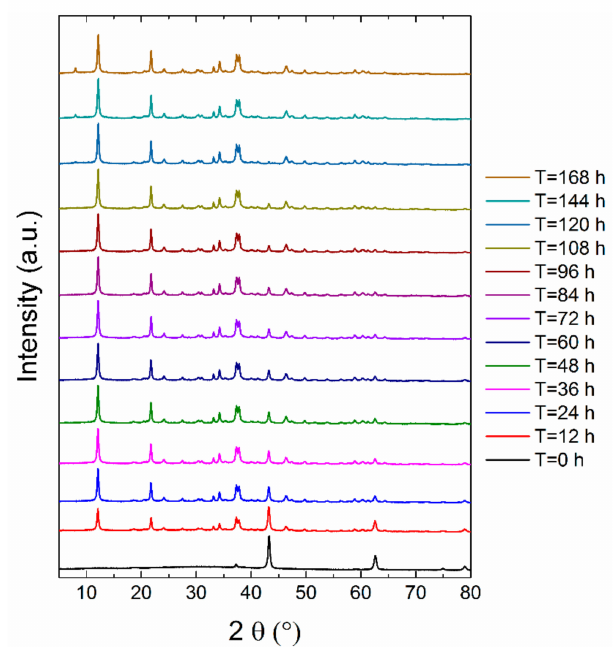
Figure 1. X-ray powder di ff raction (XRD) measurements of magnesium oxychloride cement (MOC) 5-1-8 suspensions for 168 h.